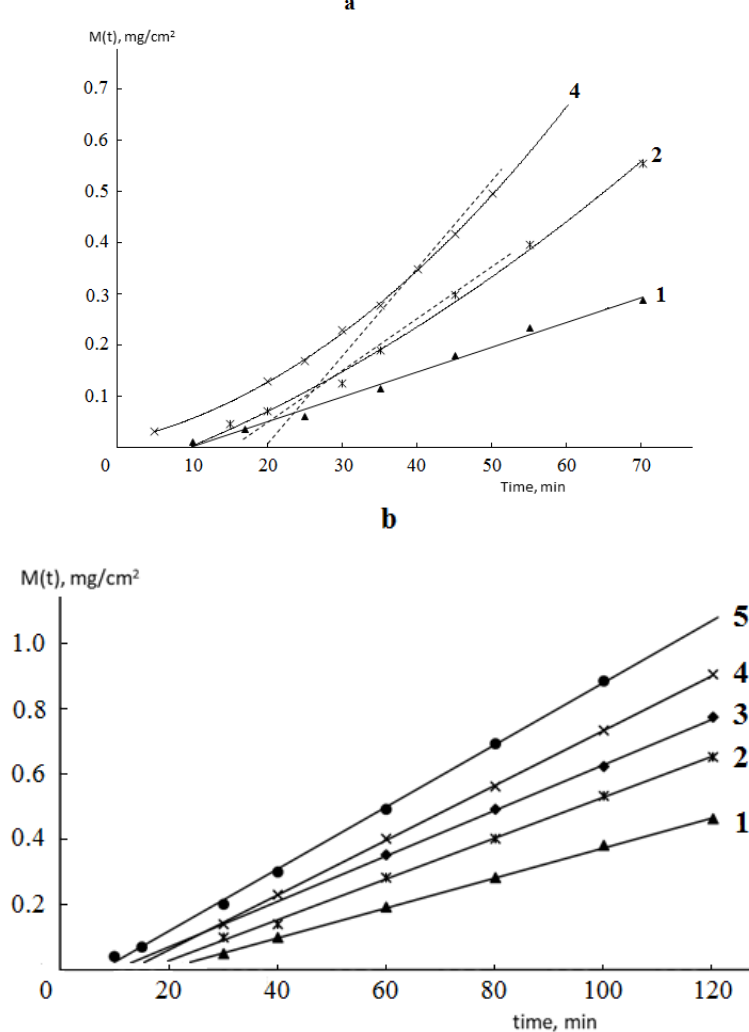
Figure 2. Kinetic curves of vapor permeability of monolithic ( a ) and porous ( b ) polymeric membranes obtained from polyvinyl chloride (PVC) ( 1 ), polyesterurethane urea (PEU)-1 ( 2 ), PEU-2 ( 3 ), PEU-3 ( 4 ), and collagen ( 5 ) at 298 K.